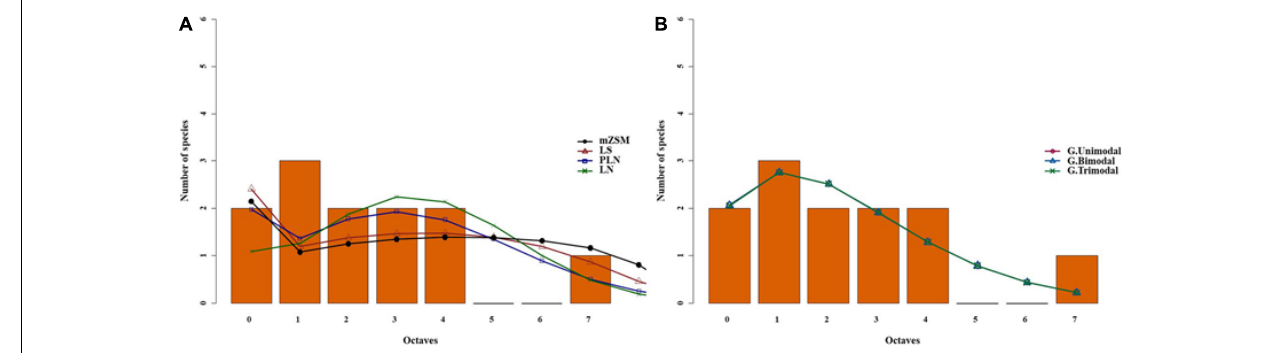
FIGURE 1 | Species abundance distribution (SAD) of carabid beetles in a Chinese desert steppe. SAD was modeled using the lognormal (LN), the Poisson-lognormal (PLN; zero-truncated version), the Fisher log-series (LS), and the metacommunity Zero-Sum Multinomial (mZSM) distributions (A) and unimodal, bimodal and trimodal gambin models (B) . LN, PLN, LS, and mZSM distributions were fitted to the raw abundance data (i.e., not binned). The data were binned for graphical comparison with gambin models, which require binning.